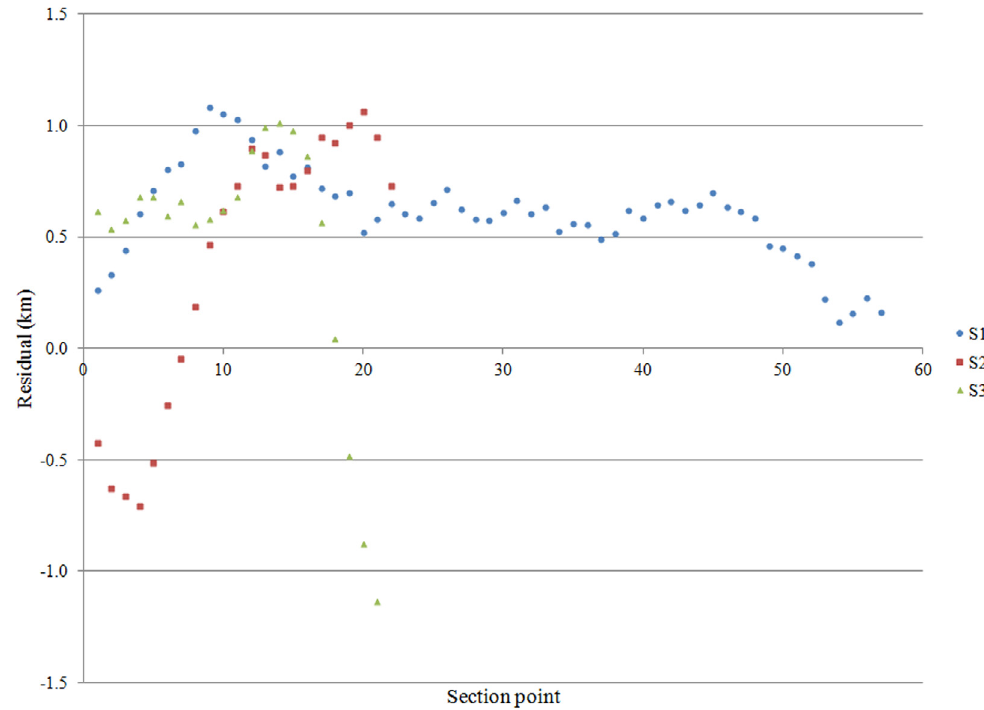
Figure 6. Integrated inversion 3: residuals on the depth